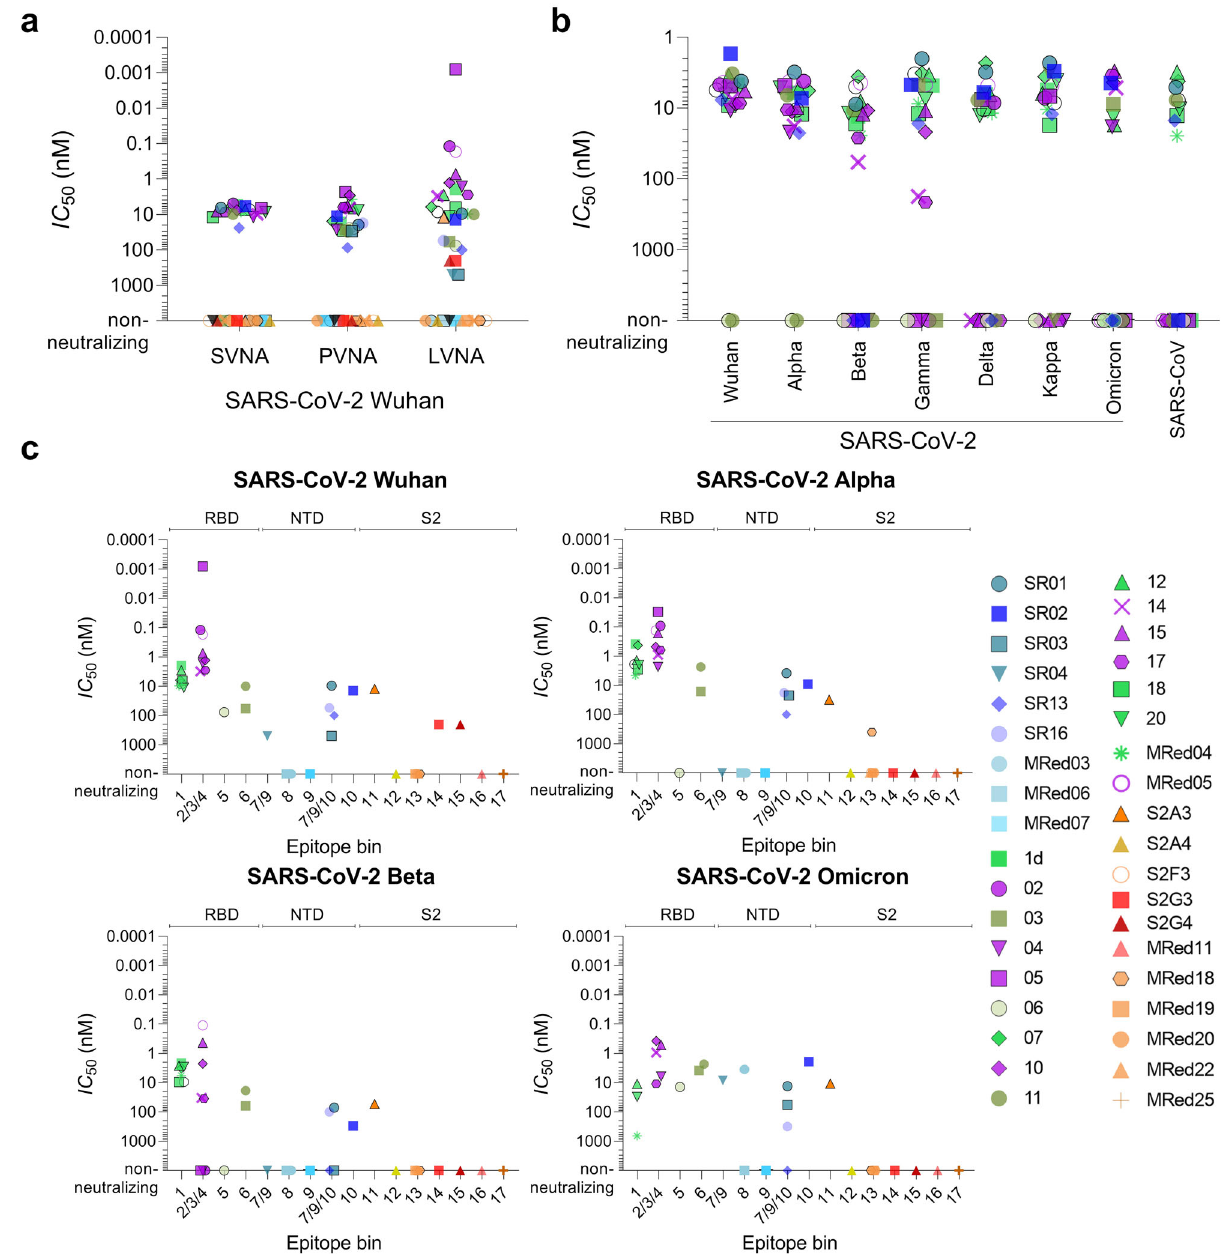
Fig. 4 In vitro neutralization potency of anti-SARS-CoV-2 S V H H-Fcs. a Summary of IC 50 s obtained by surrogate (SVNA), pseudotyped (PVNA) and live (LVNA) virus neutralization assays against SARS-CoV-2 Wuhan. b Summary of IC 50 s obtained by SVNAs against SARS-CoV-2 variants Wuhan, Alpha, Beta, Gamma, Delta, Kappa and Omicron (B.1.1.529) and SARS-CoV. c Summary of IC 50 s obtained by LVNAs for V H H-Fcs against Wuhan, Alpha, Beta and Omicron SARS-CoV-2 variants. See also Table 2 for IC 50 values. For Omicron LVNAs, only V H H-Fcs which were positive for binding to Omicron S by ELISA ( see Fig. 2a) were included. Graphs were generated based on the data in Supplementary Figs. 14 – 18 and Supplementary Table 8. Black open circle, VHH-72 benchmark. V H Hs are color-coded based on their epitope bin designation ( see Fig.